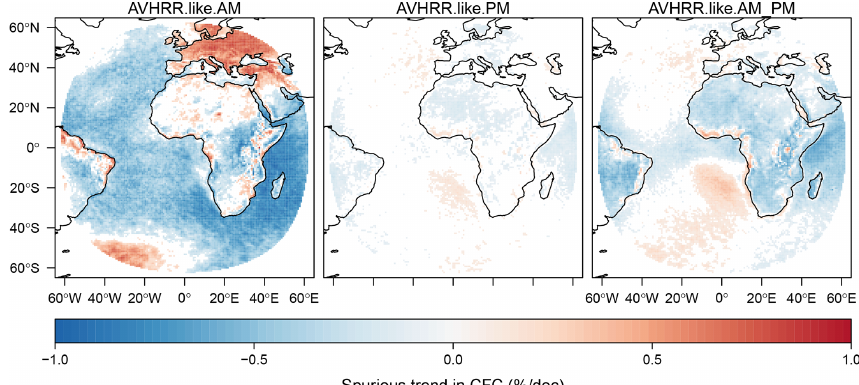
Figure 15. Spurious trends caused by orbital drift and discrete sampling of the CFC diurnal cycle presented for AVHRR-like CDRs derived from morning (AM), afternoon (PM), and combined (AM_PM) satellites. Only statistically significant trends are shown.